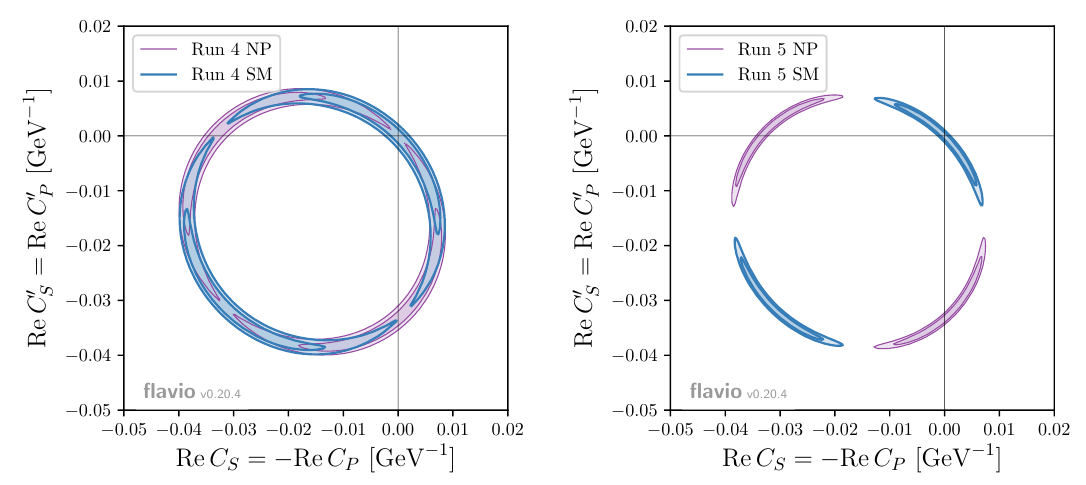
2 (cid:1) ln L 2 : 30 (cid:0) (cid:25)